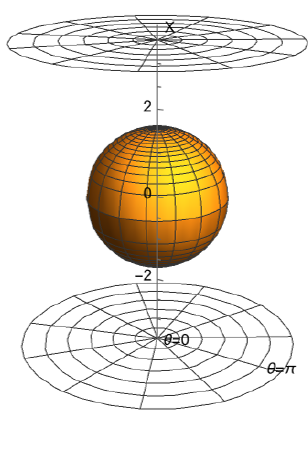
Figure 9. Maximally spherical entangling region with R = 1 . 6